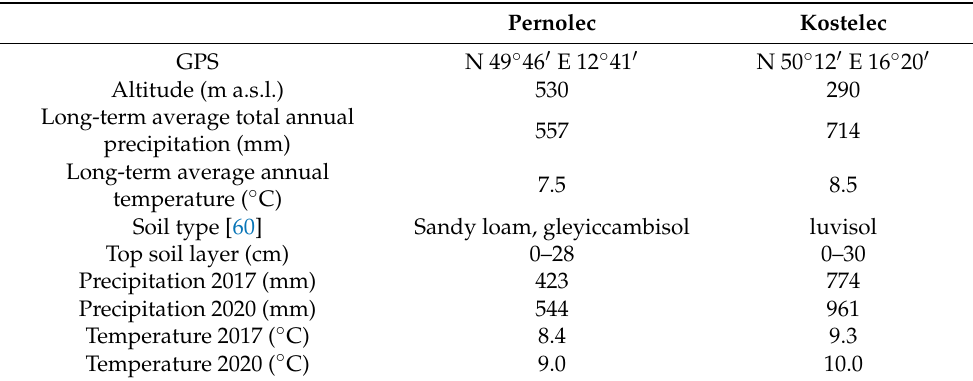
Table 1. The description of trial sites—Pernolec and